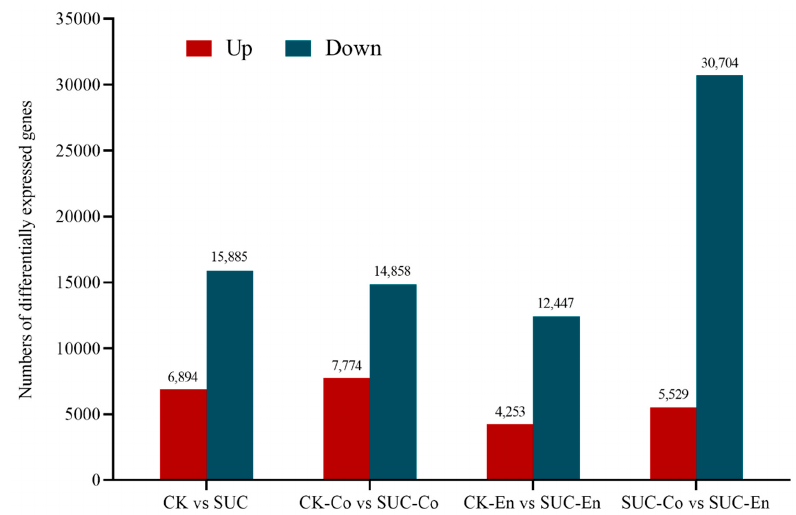
Figure 3. Statistics of the number of differentially expressed genes in four groups. The dark red represents upregulated genes, while the dark blue represents downregulated genes. CK, seed as the control; SUC, seed with sucrose treatment; CK-Co, seed coat as the control; SUC-Co, seed coat with sucrose treatment; CK-En, endosperm as the control; SUC-En, endosperm with sucrose treatment.